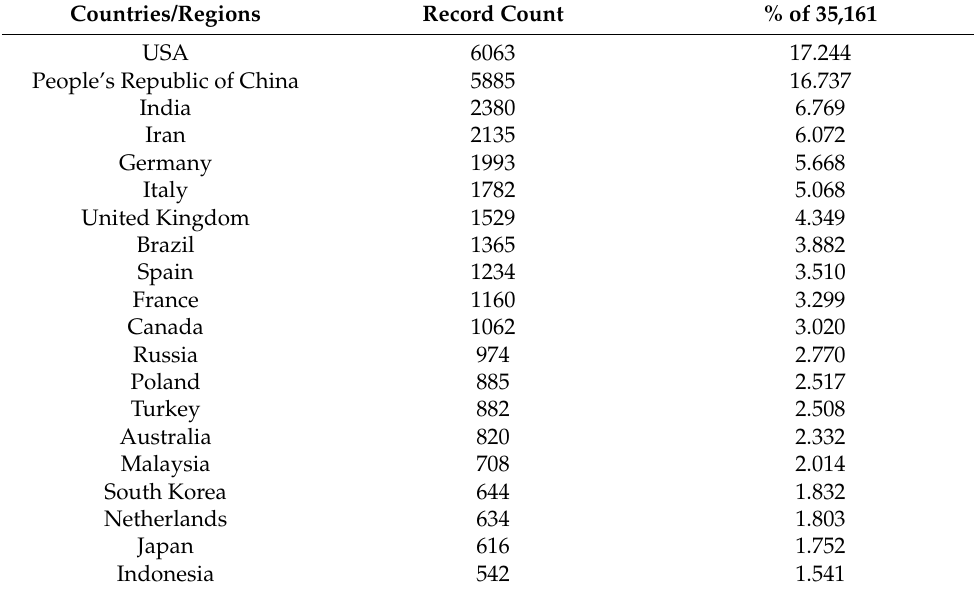
Table 11. Top 20 Countries based on the number of publications (2016–2018). Countries/Regions